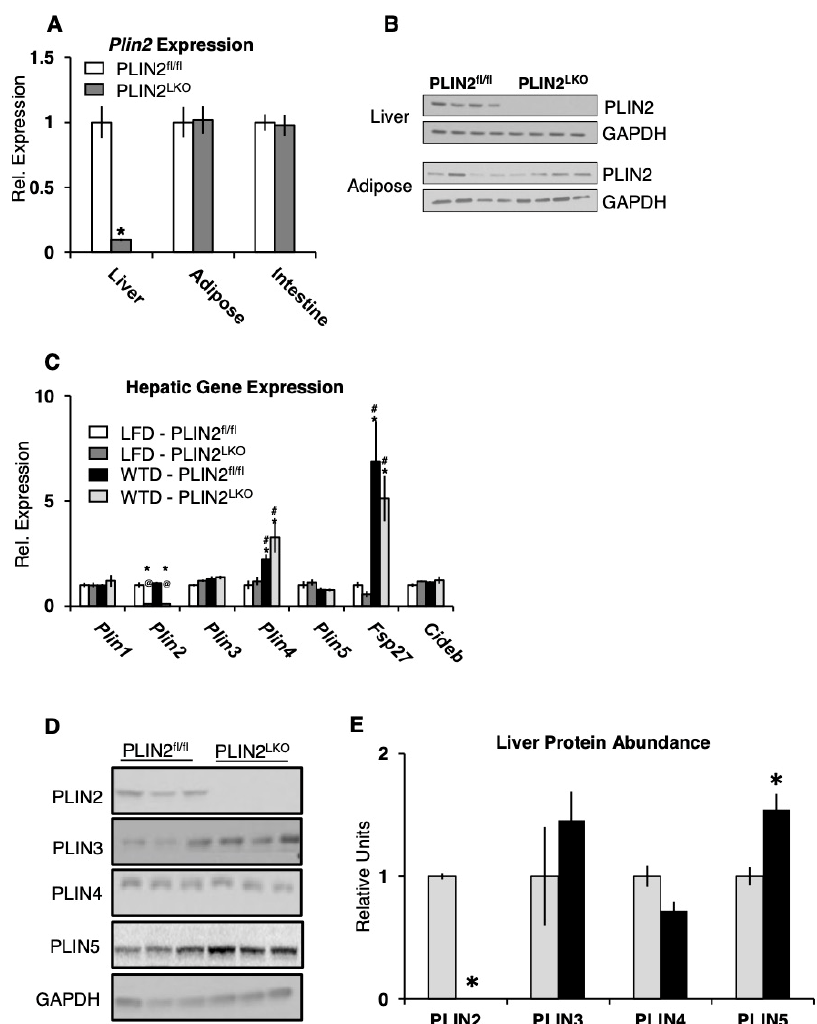
Figure 1. PLIN5 protein abundance is significantly increased by liver-specific loss of PLIN2. ( A ) Gene expression of PLIN2 in tissues from PLIN2 fl/fl (white) and PLIN2 LKO (grey) mice fed low-fat diet for 12 weeks. n = 8 – 10/group. ( B ) Representative blots of PLIN2 protein expression in liver and adipose from mice fed a Western-type diet for 12 weeks. ( C ) Gene expression in liver of 20-week-old mice following 12 weeks of LFD or WTD treatment. n = 8 – 13/group. Data are presented as the mean ± SEM. * p ≤ 0.05 vs. LFD – PLIN2 fl/fl , # p ≤ 0.05 vs. LFD – PLIN2 LKO , and @ p ≤ 0.05 vs. WTD – PLIN2 fl/fl , as determined by two- way ANOVA and Tukey’s post hoc analysis. ( D ) Representative blots and ( E ) densitometric analysis of PLIN protein abundance in liver following 12 weeks of WTD treatment. Data are presented as the mean ± SEM. * p ≤ 0.05 vs. WTD – PLIN2 fl/fl , as determined by student’s t